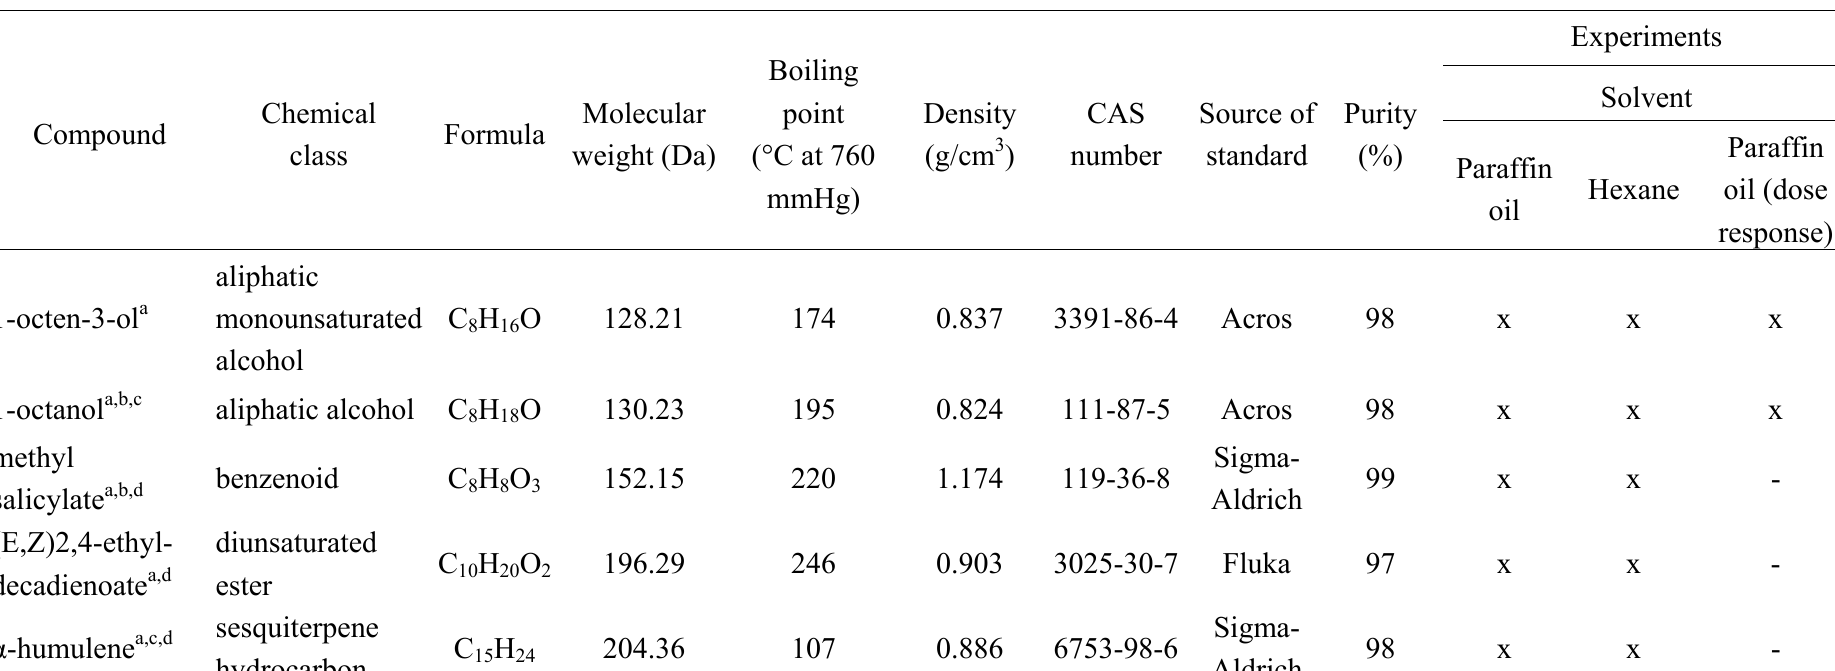
Table 1. List of compounds used as stimuli in the experiments and their chemical